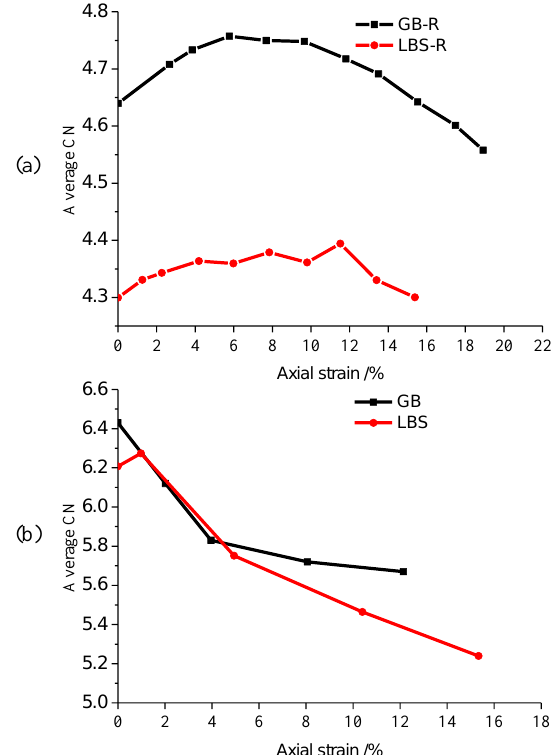
Fig. 3 Sand-sand contact coordination number evolution: (a) in GB-R and LBS-R samples; (b) in GB and LBS samples To quantify the fabric anisotropy of sand-sand contacts and sand-rubber contacts, anisotropy degree 𝑎 of sand-sand contacts and sand-rubber contacts were calculated based on the orientations of sand-sand branch vectors and sand-rubber branch vectors, respectively [13]. Specifically, the sand-sand branch fabric